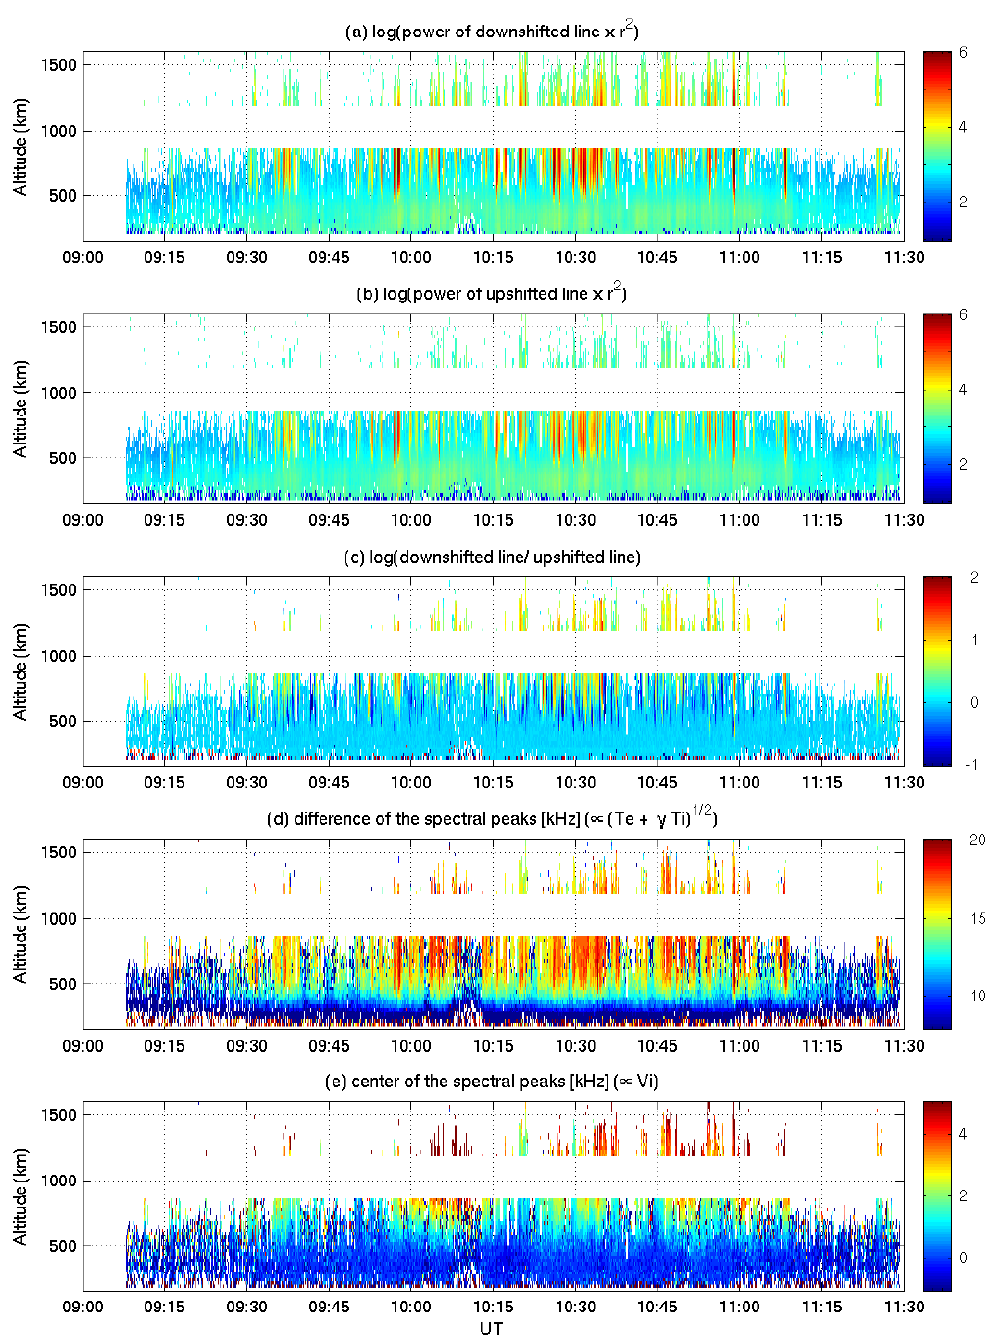
Fig. 5. Fig. 5. Color-coded height-time profiles of 10s raw data obtained by the ESR between 09:00 and 11:30 UT on 28 July 2000. They are, from top to bottom, peak power of upgoing/downshifted line and of the downgoing/upshifted one, ratio of the downshifted to upshifted peak energies, distance in frequency between downshifted and upshifted peaks, and center frequency between the downshifted and upshifted peaks,